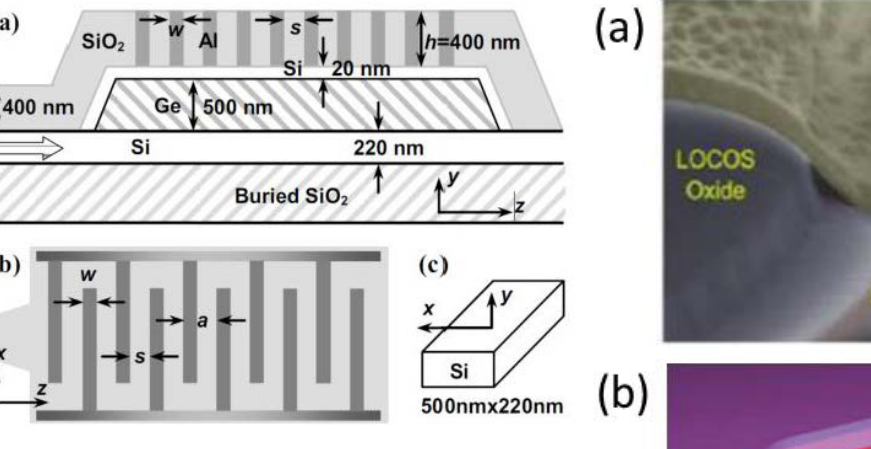
Figure 10: Scheme of the Ge-on-SOI MSM photodetector with inter- digitated electrodes. (a) Cross-sectional view of the device. (b) Top view of the interdigitated fingers. (c) Perspective view of the Si core layer with thickness of 220 nm and width of 500 nm where light propagates in the z-direction. Figures with reprint permission from: (a), (b) and (c) Ref. [20] ©2010 American Institute of Physics.